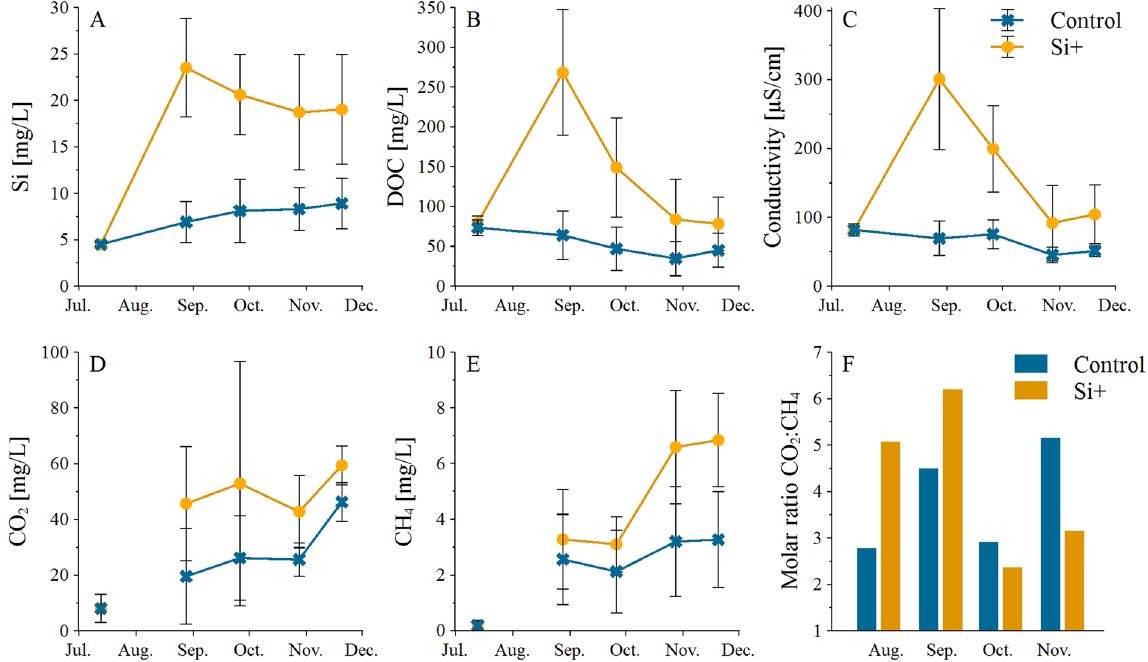
Figure 1. Mean ± SD values of Si, DOC, CH 4 , and CO 2 concentrations, conductivity, and the molar ratio CO